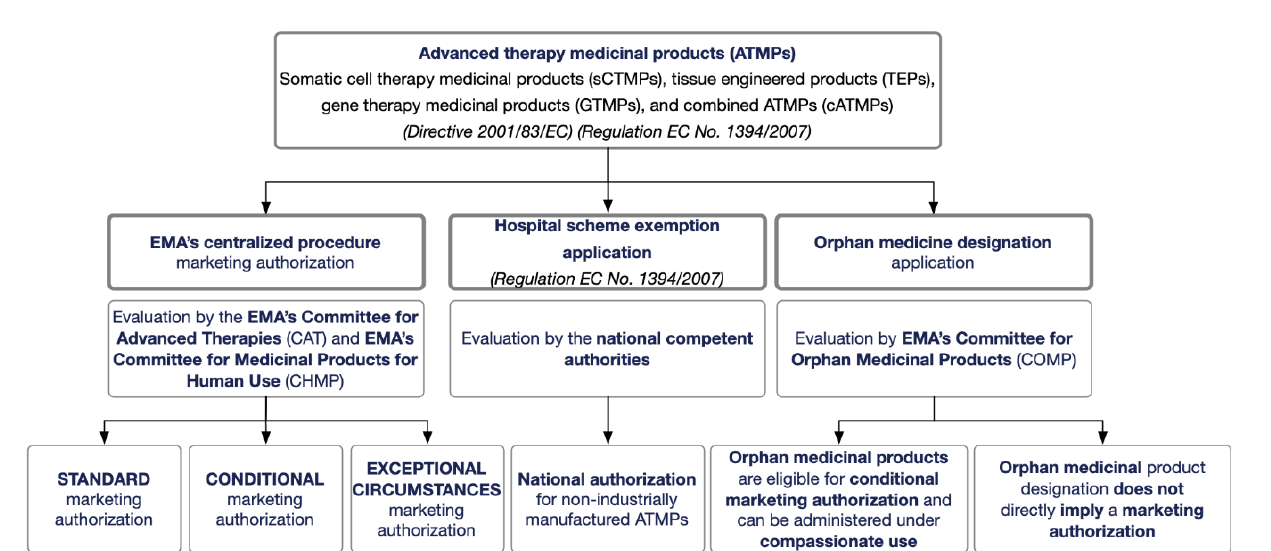
Figure 1. Regulatory pathway for advanced therapy medicinal products (ATMPs) in the European Union (EU). The European Medicines Agency (EMA) is responsible for implementing this regulatory framework in cooperation with the national regulatory agencies from each EU member state.